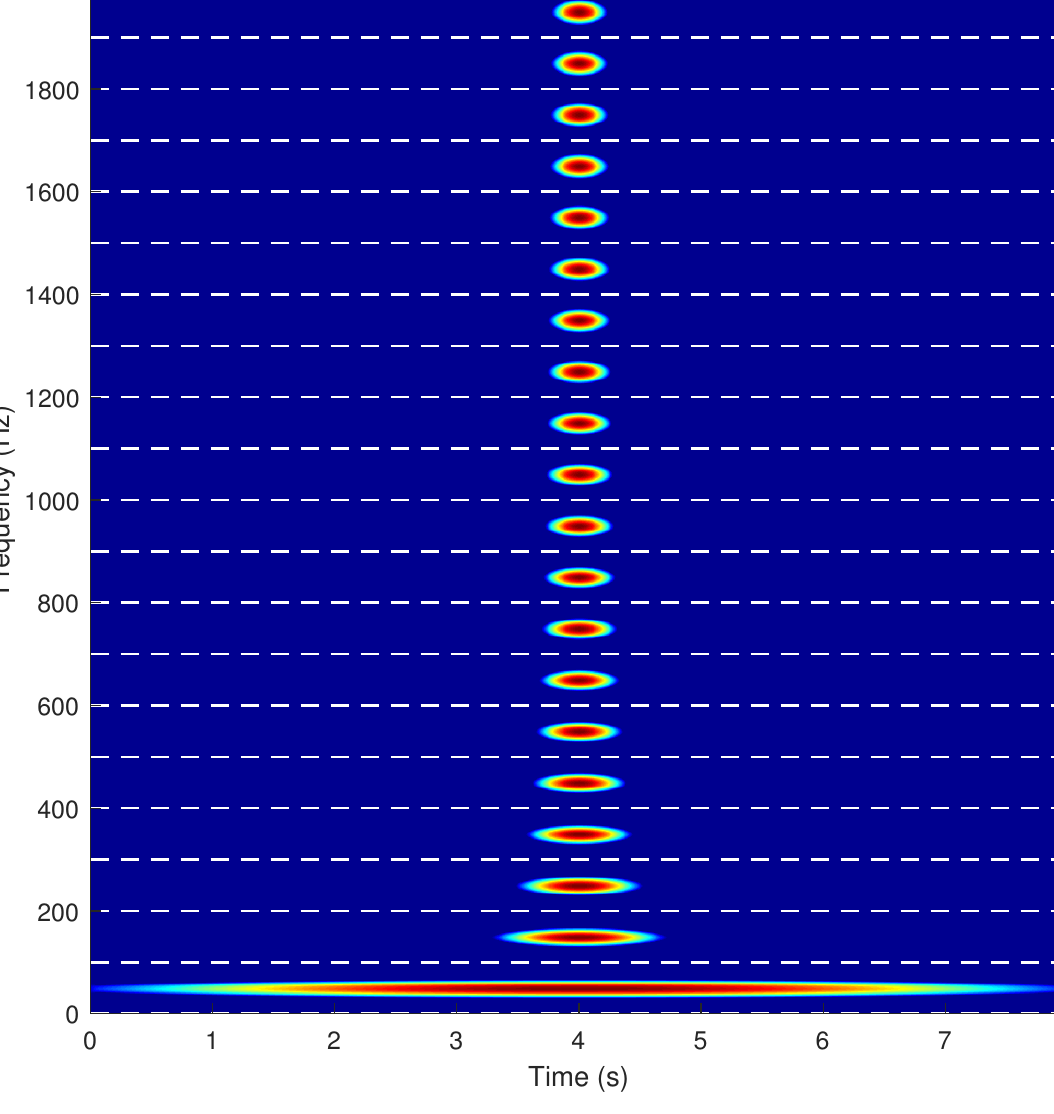
Figure 2. Atoms of the multi-band window designed in Section 3 in the joint time-frequency domain. This window contains 20 Gaussian windows, located in 20 adjacent frequency bands of 100 Hz, spanning linearly the range from α = 1 (bottom) up to α = 700